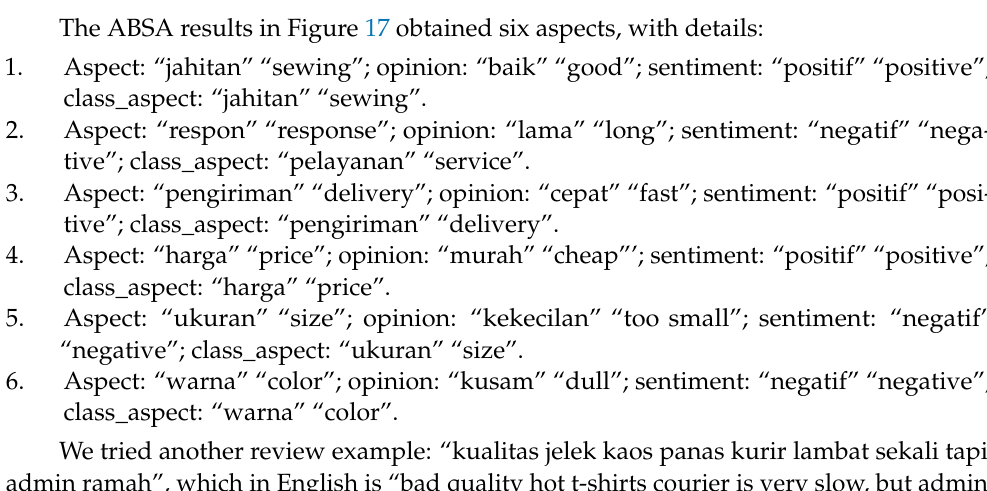
Figure 17. The example-1 of using the ABSA model.